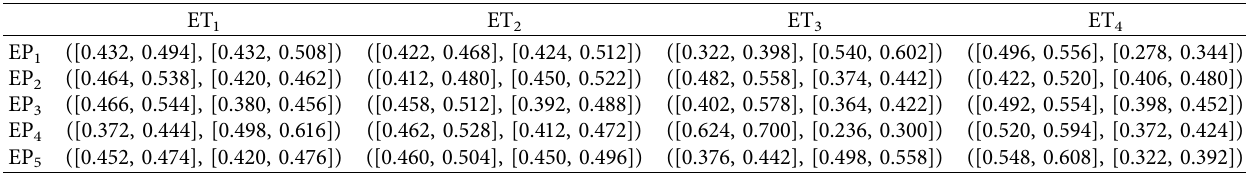
Table 6: Overall IVIF evaluation